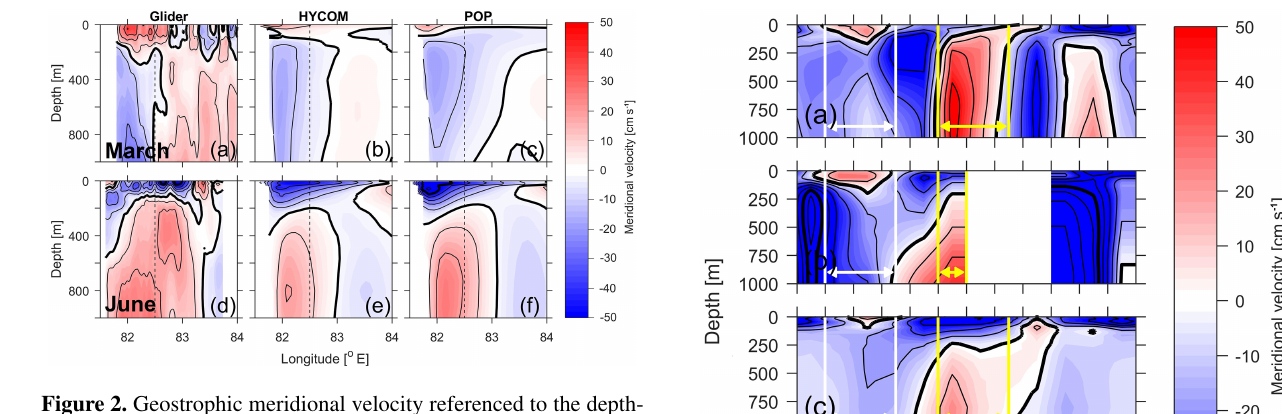
Figure 2. Geostrophic meridional velocity referenced to the depth- averaged velocity across 8 ◦ N from glider measurements during 18– 30 March 2014 (a) and 24 May–8 June 2014 (d) , the mean total meridional velocity from HYCOM ( b and e ) and POP ( c and f ) in March and June over 2003–2012 and 1995–2007 periods, respec- tively. The black dashed line marks the typical eastern extent of the undercurrent core; the region bounded to its west is used for a subsequent averaging in Fig. 3. Thin black lines are plotted every 10cms − 1 , and thick black lines are plotted every 50cms − 1 .